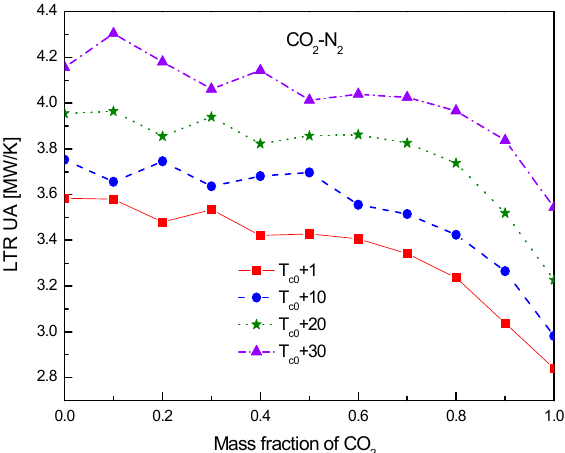
Figure 23. LTR conductance of CO 2 -N 2 at different compressor inlet temperatures.